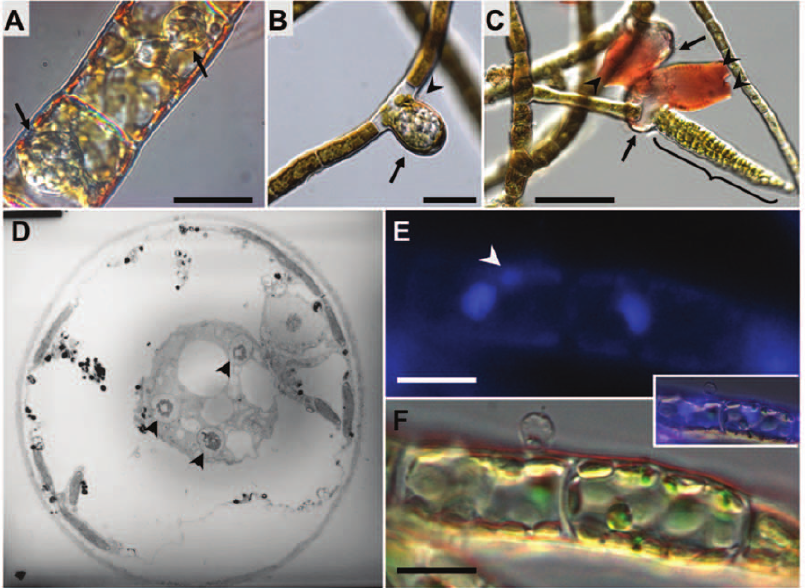
Figure 1. Co-localisation of E.siliculosus nuclei and Eu.dicksoniithalli . A, B, C: Successive stages of Ectocarpus infection by Eurychasma dicksonii . The Eu. dicksonii thallus develops as a spherical intracellular syncitium (A, arrows), progressively filling any individually infected algal cell, ultimately causing its hypertrophy (B, arrow). The syncitium then differentiates into a sporangium (C, arrows, Congo red staining) that releases new infectious spores into the medium via its apical apertures (C, arrowheads). The original infectious spore at the surface of the infected Ectocarpus cell is visible in B (arrowhead). The structure designated with a brace in C is an algal plurilocular sporangium containing parthenogenetic zoospores. Bars: A, B: 20 mm; C: 50 mm. D. Eu. dicksonii syncyitium (3 nuclei visible, arrowheads) developing next to the nucleus of a highly vacuolated E. siliculosus cell (strain CCAP 1310/299). Picture: courtesy of Dr S. Sekimoto. E & F. DAPI staining (E) and corresponding Nomarski image (F) of the microscopic sexual development stage (gametophyte) of the kelp Macrocystis pyrifera infected with Eurychasma dicksonii . The left hand side algal cell contains a very young Eurychasma thallus (one nucleus visible, white arrowhead) derived from the protoplasm of the empty spore visible at its surface. Insert: merged images. Scale bar: 10 um.